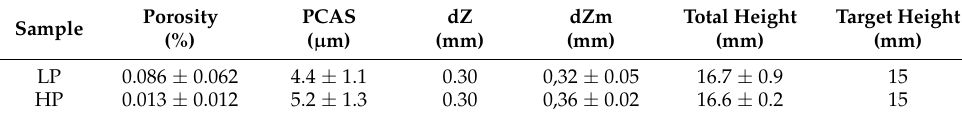
Table 2. Data of cubes built with high power and low power